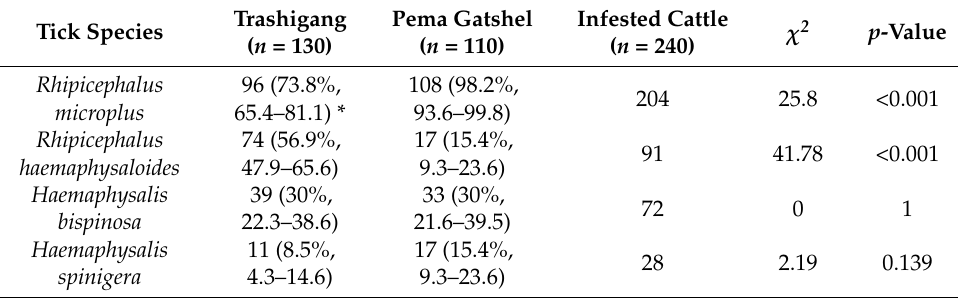
Figure 4. Dorsal and ventral views of male ( A ) and female ( B ) of Amblyomma testudinarium ; and female ( C ) Ixodes sp. Table 4. Tick infestation prevalence in cattle in Trashigang and Pema Gatshel districts. Tick Species